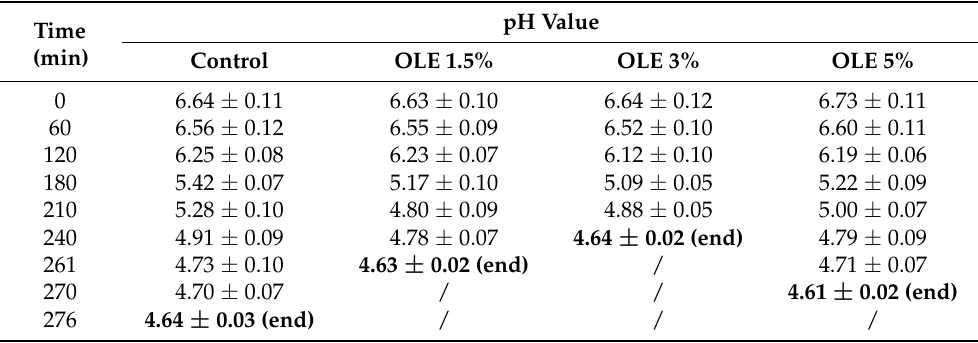
Table 1. Average pH values measured during fermentation in different yoghurt samples (control, OLE 1.5%, OLE 3%, and OLE